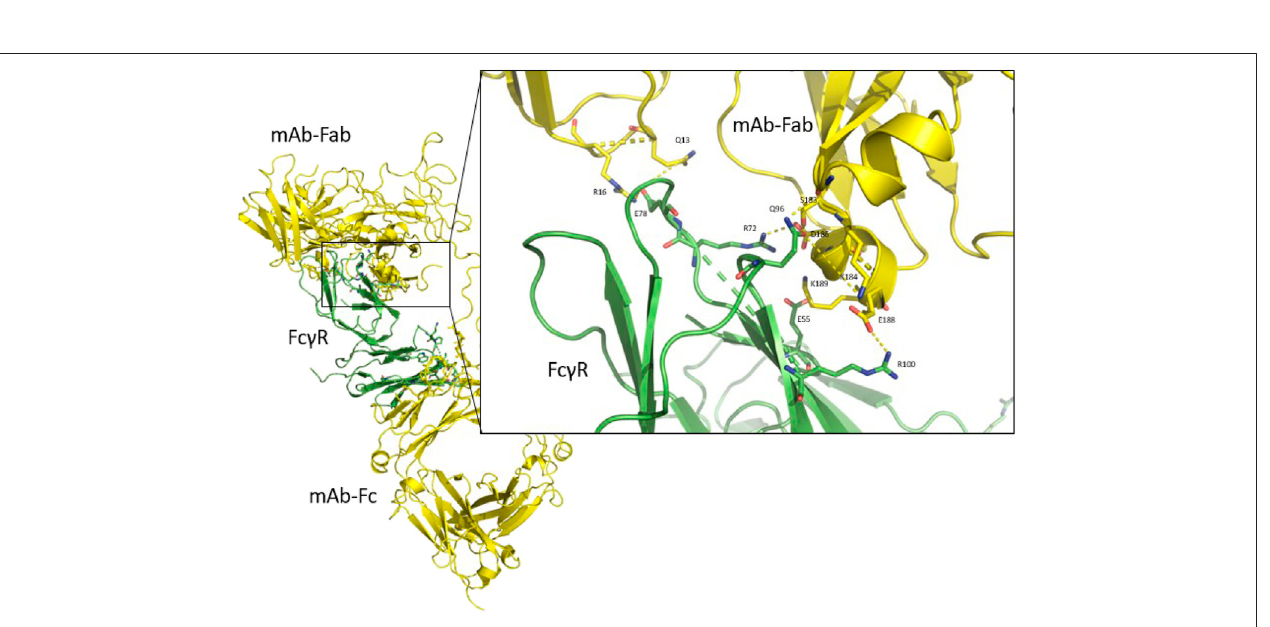
Frontiers in Chemistry |